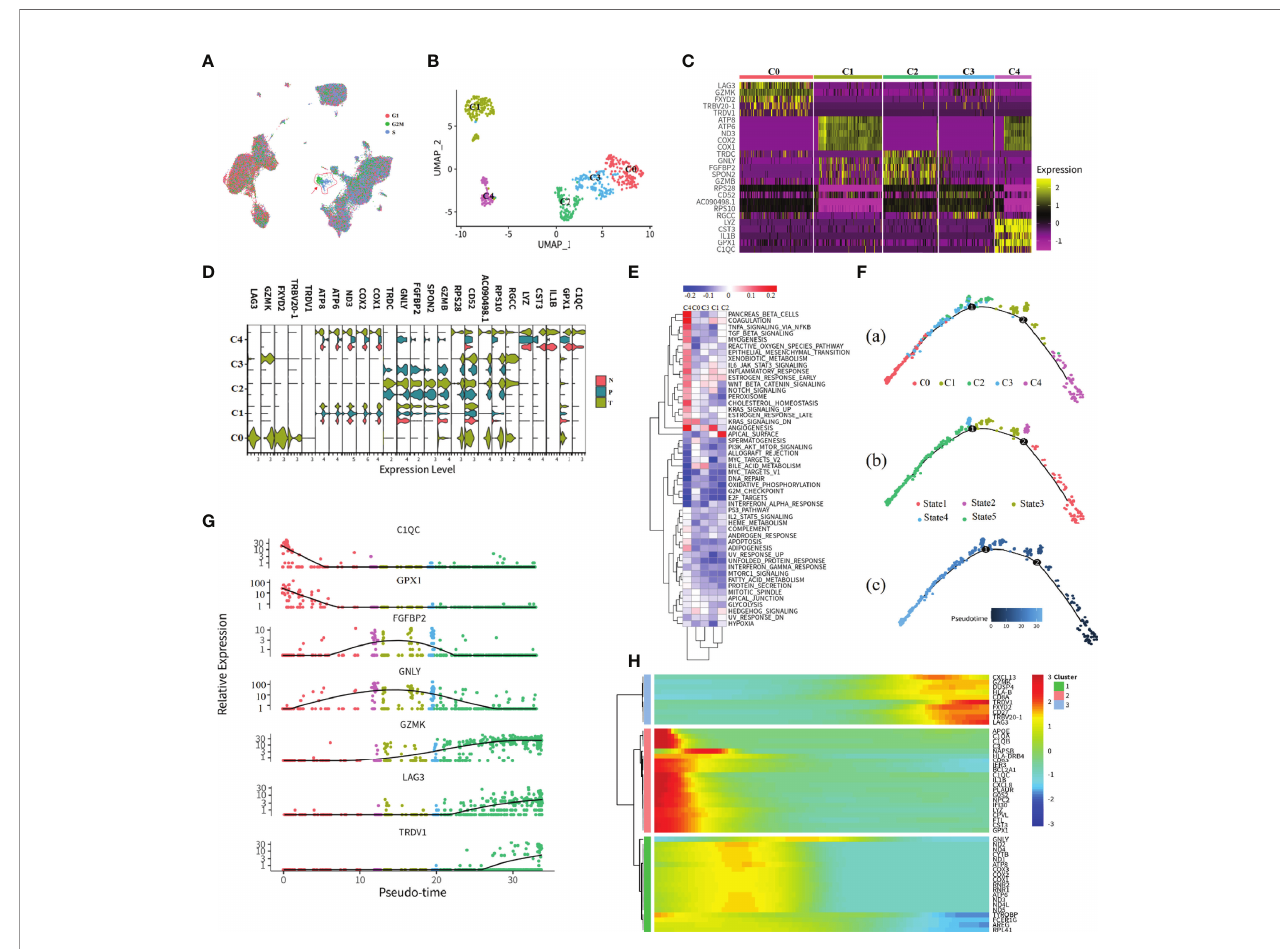
FIGURE 3 | Subtypes and development trajectory of CD8+ T_3 cells. (A, B) UMAP visualization of all cell types (A) or CD8+ T_3 subtype (B) . Each dot corresponds to a single cell, colored according to cell cycle state or subtype. (C) Heatmap of selected markers for the CD8+ T_3 subcluster. (D) Violin plot of the CD8+ T_3 subtype in different tissue types. (E) Hallmark enrichment visualization of each subtype. The redder color indicates an upregulated pathway activity; the bluer color means downregulated pathway activity. (F – H) Illustration of CD8+ T_3 cell development trajectory inferred by monocle2, and canonical markers of each state were selected to visualize the cell development. Heatmap showing relative expressions of canonical markers of CD8+ T_3 cells along inferred trajectories. The red and blue colors correspond to the relative gene expression